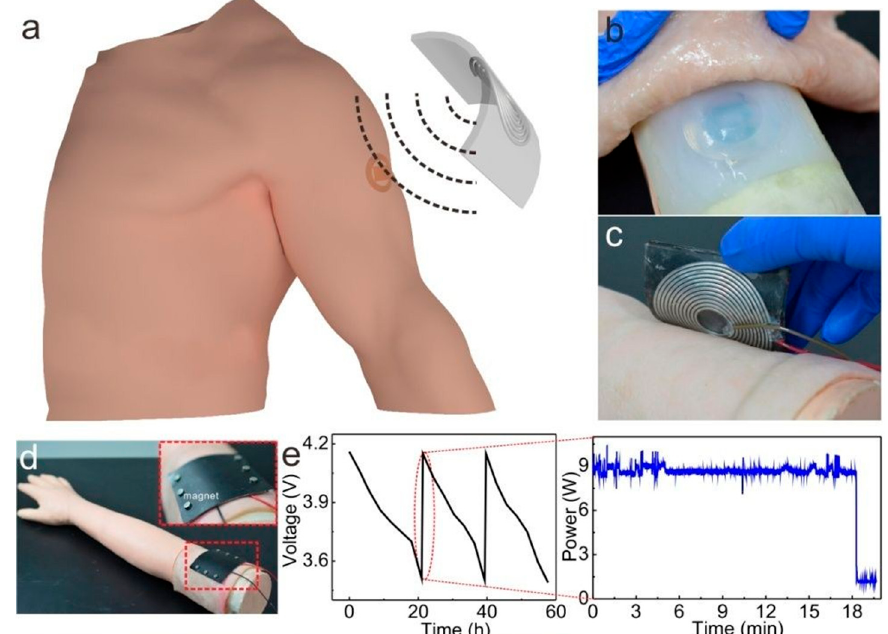
Figure 13. ( a ) Illustration depicting wireless charging of implantable LM coil; ( b ) compliant LM receiver implanted in pigskin; ( c , d ) wireless charging of the implanted device; ( e ) change in voltage of the implanted 120 mAh battery during discharge/charge cycles (left) and input RF power at transmission coil during the 18 min charging cycle (right) [77].